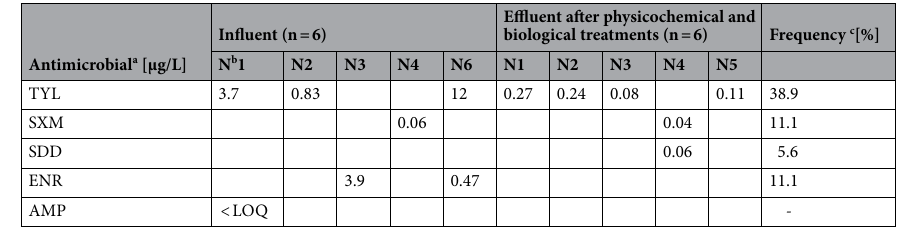
Table 1. Antimicrobial residues detected in wastewater samples from the in-house WWTP of the examined poultry slaughterhouse. a Abbreviations for antimicrobial agents: TYL tylosin, SXM sulfamethoxazole, SDD sulfadimidine, ENR enrofloxacin, AMP ampicillin. b N—Sampling number. c Only samples with concentrations > LOQ were used for the